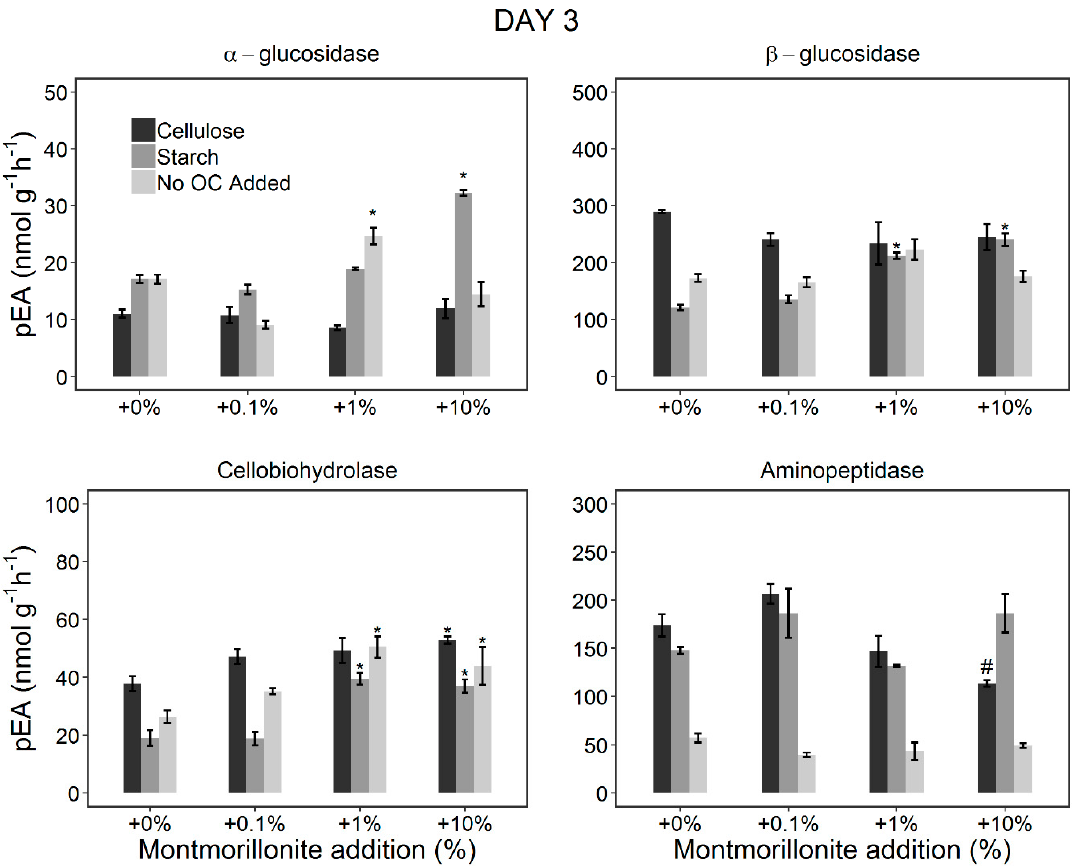
Figure 3. The potential enzyme activities (pEA) of α -glucosidase (AG), β -glucosidase (BG), cellobiohydrolase (CB), and aminopeptidase (AM) measured in the soil manipulated by increasing montmorillonite addition without added OC or with the addition of OC (starch or cellulose) at day 3 of the incubation. Error bars represent standard error of means (n = 3). Bars with statistical significant difference ( p < 0.05) from the control (+0%) are marked with * (increase in pEA) and # (decrease in pEA). Mean comparison was done among treatments in the same group (cellulose or starch).